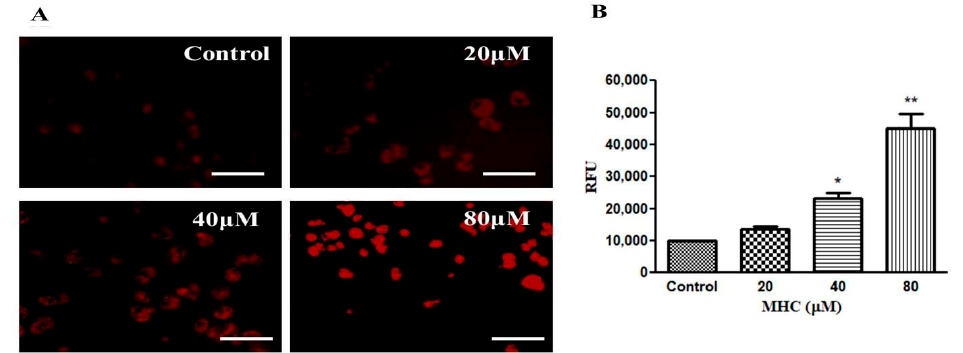
Figure 5. MHC-mediated instigation of apoptosis within MCF-7 cells as evaluated through ( A ) fluorescent photomicrographs of MCF-7 cells stained using PI and ( B ) its quantification. Scale bar 100 µm. * p < 0.05, and ** p < 0.01